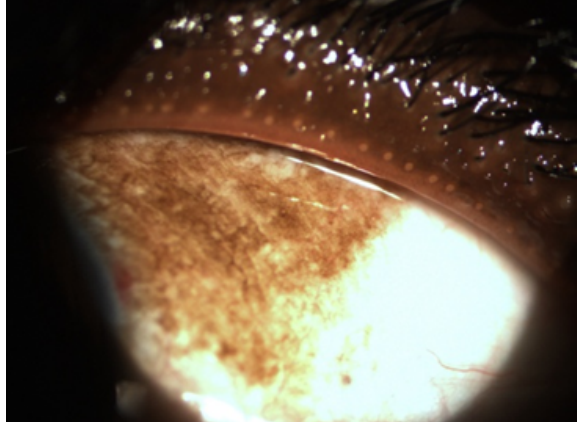
Figure 3: Clinical appearance of the temporal lesion at bulbar conjunctiva